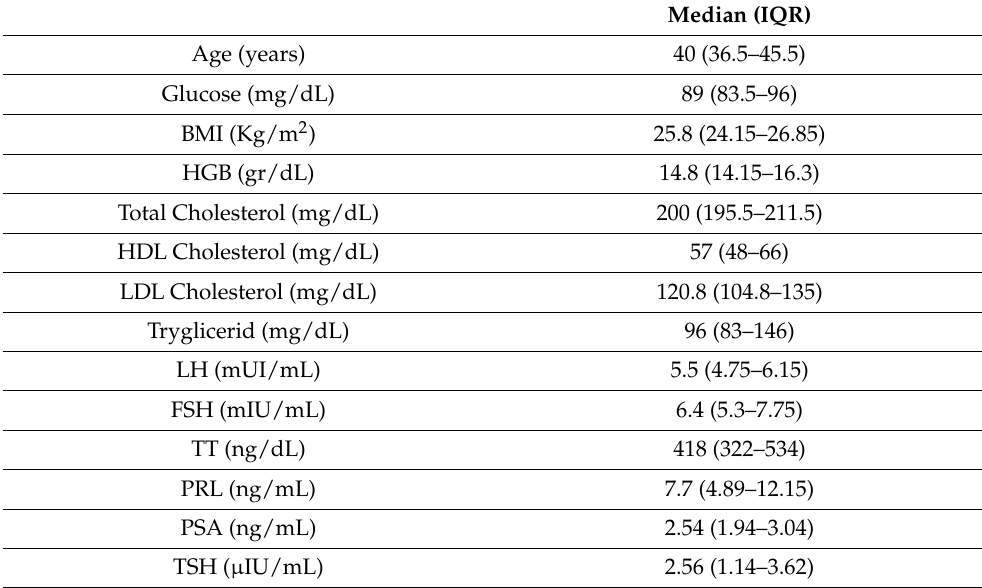
Table 1. Characteristics of the enrolled patients.